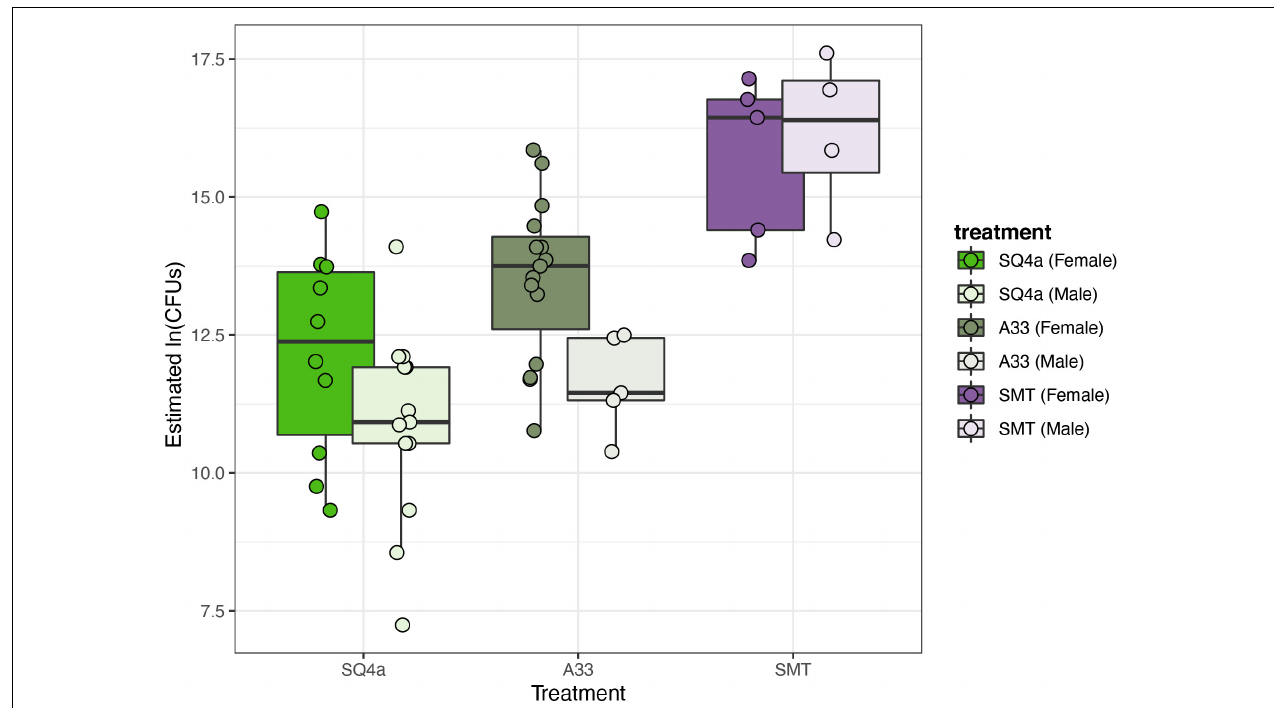
FIGURE 10 | Estimated population sizes of alternative Burkholderiaceae strains in adult crypts. The populations sizes in crypts of the three strains that established in adult bugs differed significantly, with SMT, the Paraburkholderia sp. strain that provided less fitness benefits ( Figure 8 ), establishing the largest populations. Each point represents the estimated population within the M4 crypts of one